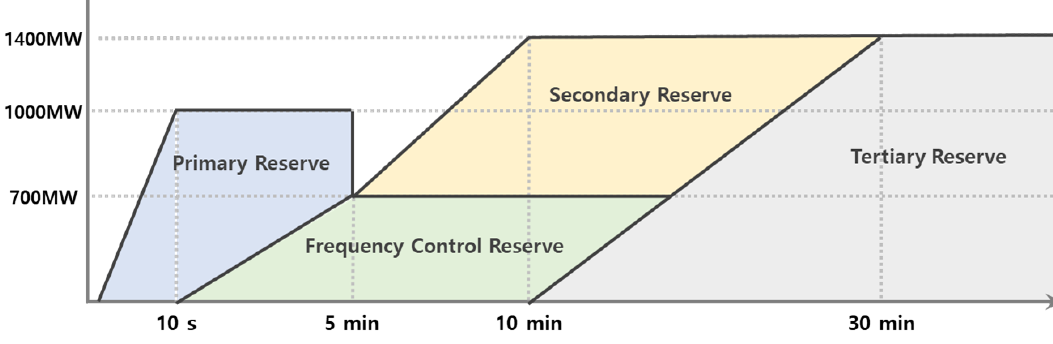
Figure 3. Concept of amended ancillary service in the Korean power system.